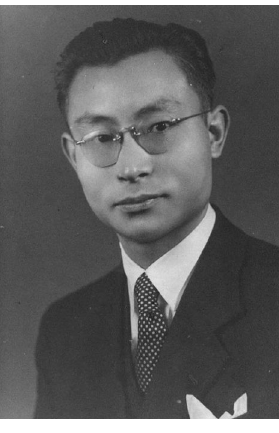
Figure 3. Dr. Shen was advising his graduate students at Beijing Medical University (now part of Peking University)